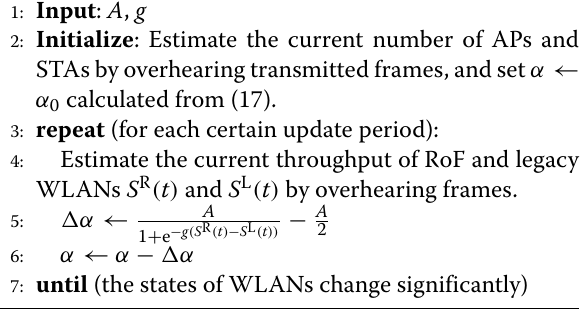
Algorithm 1 Adaptive transmission probability